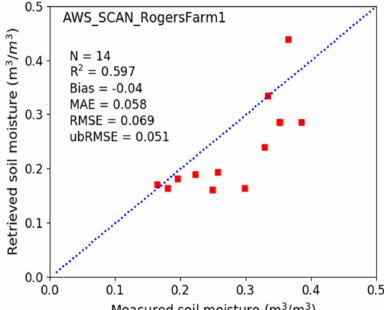
Figure 9. Soil moisture retrievals from the SCA-VV algorithm plotted against the point-scale measurements from the Rogers Farm #1 SCAN site in Nebraska (see https: // wcc.sc.egov.usda.gov / nwcc / site?sitenum =